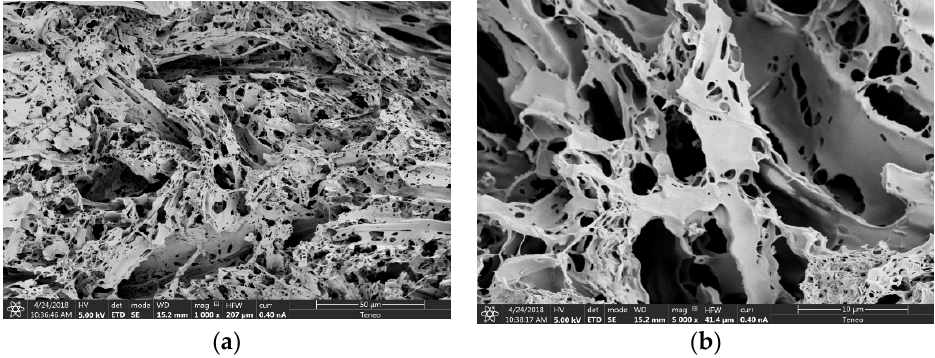
Figure 9. SEM images of PBS_CL tablets obtained by USAC (23:77% v/v) after drug release. Detail of the nanostructured matrix ( a ) 1000× ( b ) 5000×.